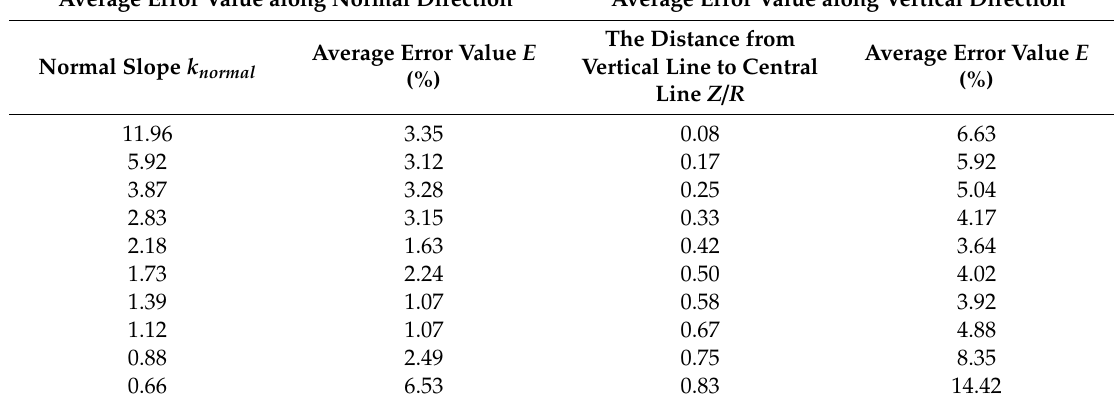
Table 2. Comparison of the application of the log-law in normal and vertical lines, with condition C1: H = 0.0813.